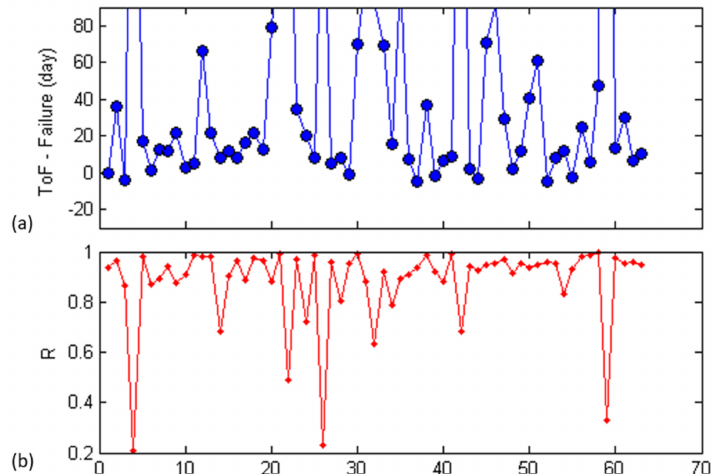
Figure 17. Relation between the error of predictions obtained with the INV method ( a ) and R values ( b ). The error of prediction is reported on the y-axis as the difference in days between the computed ToF and the actual failure time. The ID of predictions is listed on the x-axis. The graph refers to the forecasting analysis applied on the time interval included from the breakpoint time to the last acquisition (19 June